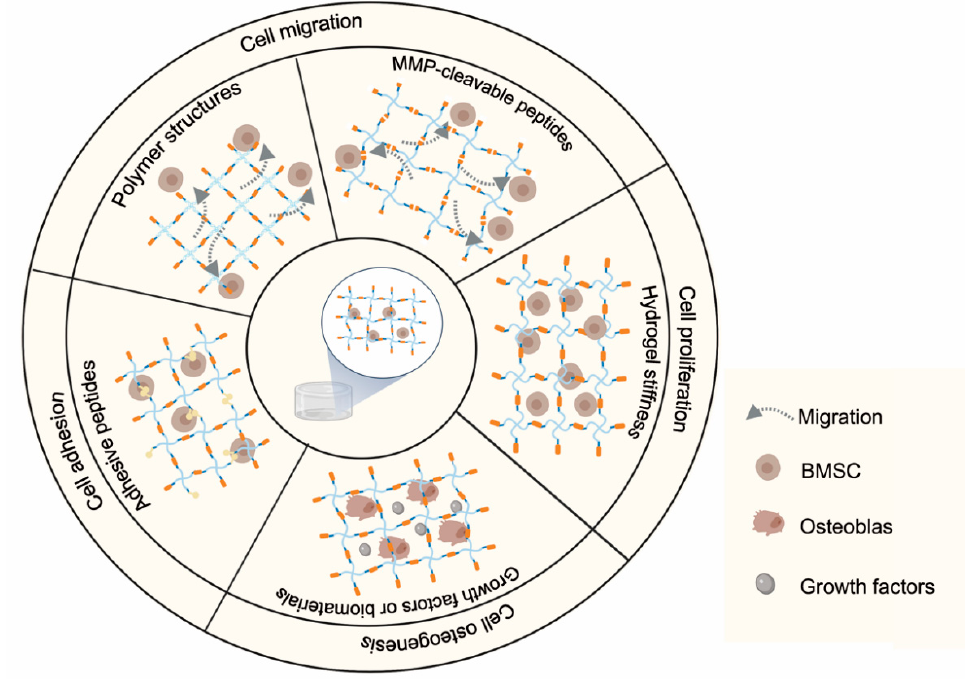
Figure 5. Illustration diagram of MMP-cleavable hydrogel-based 3D in vitro models for studying cellular responses.